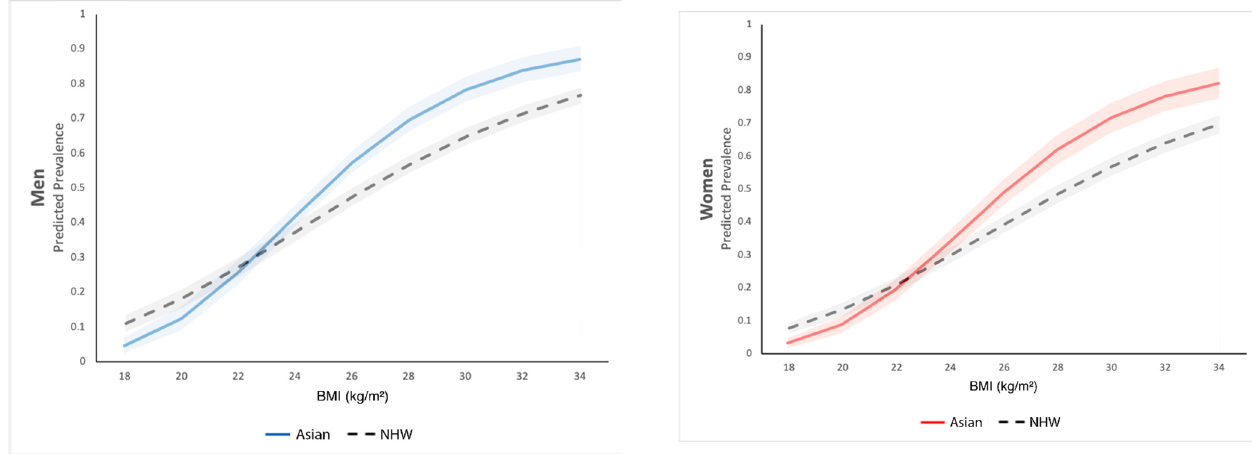
Figure 1. Predicted prevalence of MetS by BMI, compared between Asian Americans and non-Hispanic Whites.